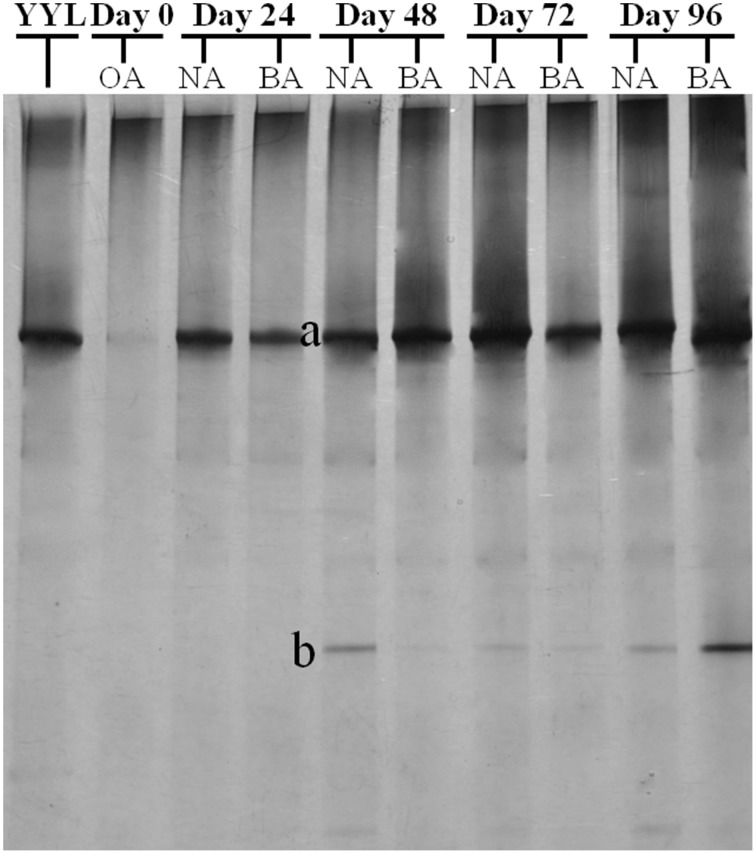
DGGE fingerprinting profiles of the SDIMO gene from the activated sludge samples at different periods during reactor operation, indicating the change in microbial diversity and community composition. YYL, represents the THF monooxygenases of Rhodococcus sp. YYL; OA, represents the original activated sludge; NA, represents the activated sludge from non-trehalose BA reactor; BA, represents the activated sludge from the trehalose BA reactor.